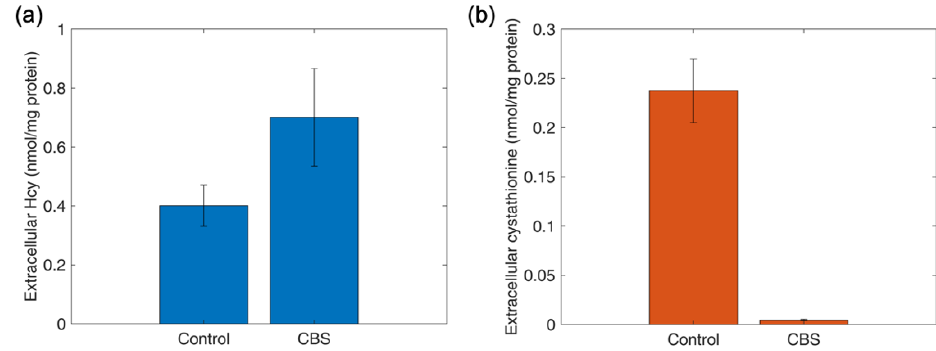
Figure 7. Analysis of marker thiol and thioether metabolites in cystathionine β -synthase deficiency. Cystathionine β -synthase catalyzes the conversion of serine and homocysteine into cystathionine. Panel ( a ). Export of reaction co-substrate Hcy into conditioned culture medium after 7 days by a control subject and a B6-responsive CBS-deficient patient. Panel ( b ). Export of transsulfuration reaction product Cysta into conditioned culture medium after 7 days by a control subject and the B6-responsive CBS-deficient patient.